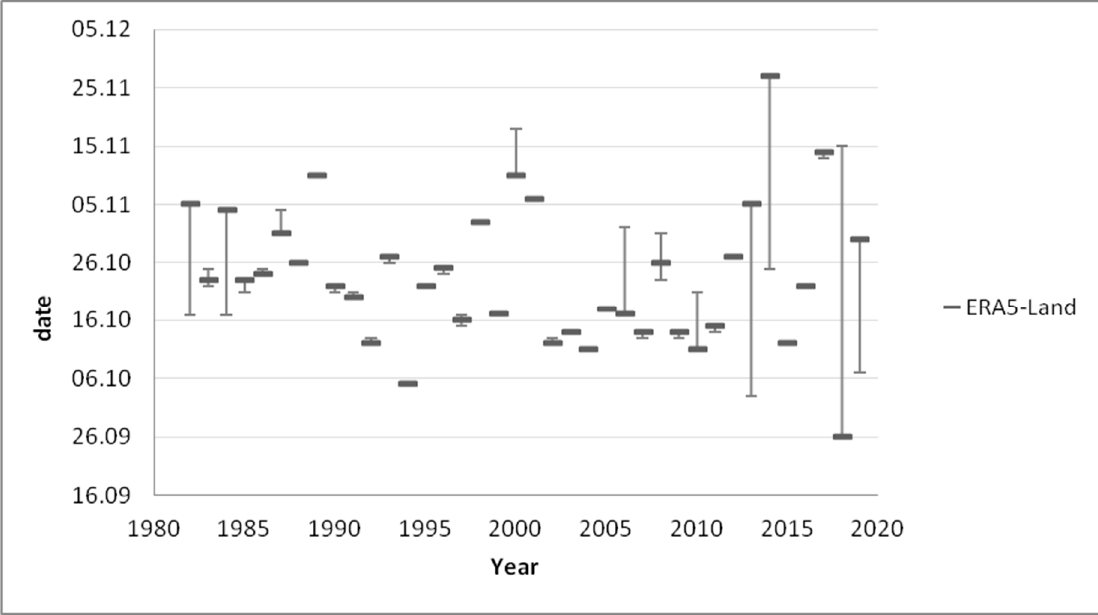
Figure 9. Graph of first fall frost dates with uncertainties between the years 1982 and 2019.